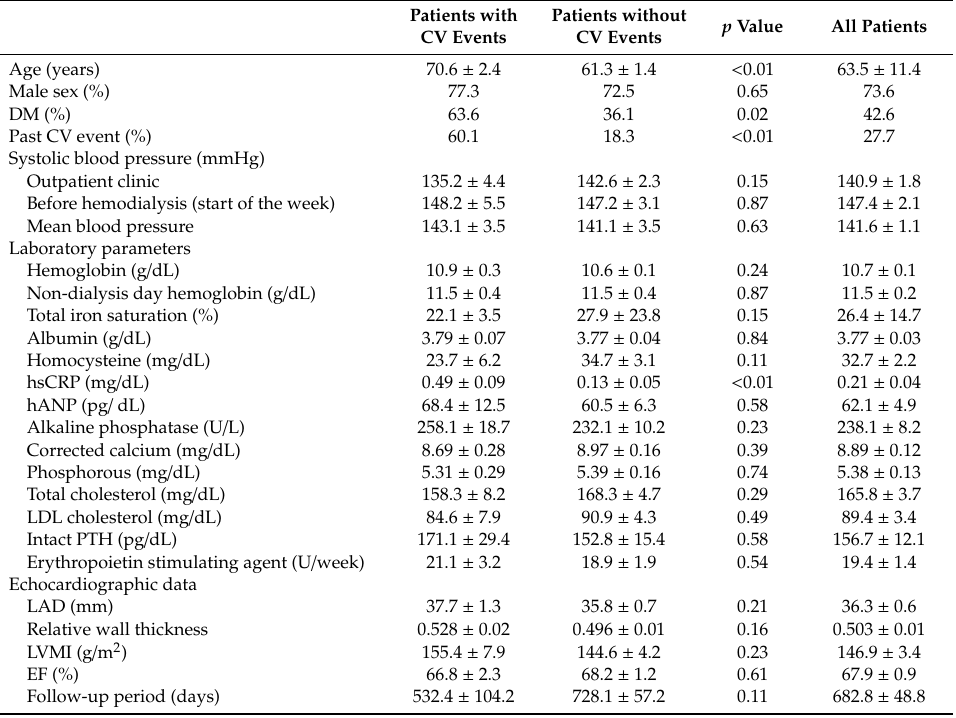
Table 1. ANOVA of characteristics between patients with and without CV events 12 months after initiation of